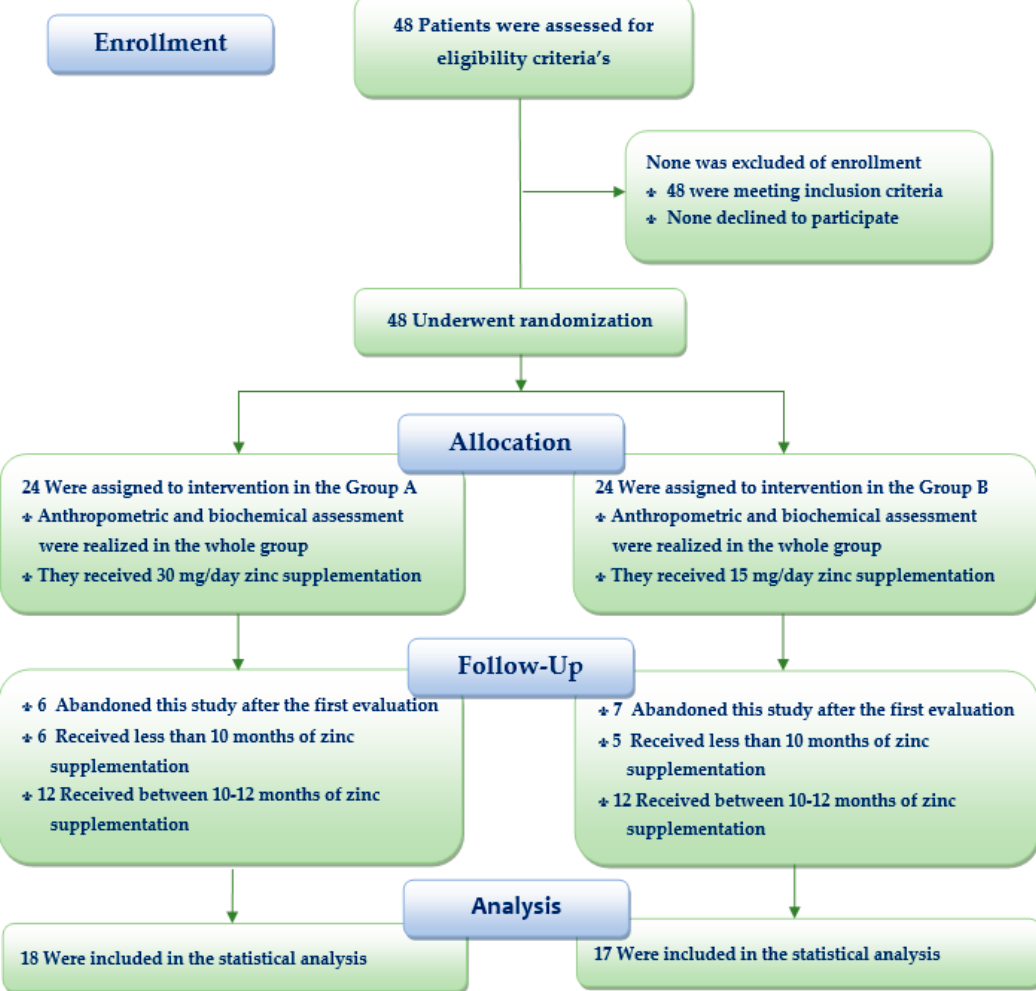
Figure 1. Flow diagram the effect of two doses of zinc supplementation on nutritional status in children with chronic kidney disease.